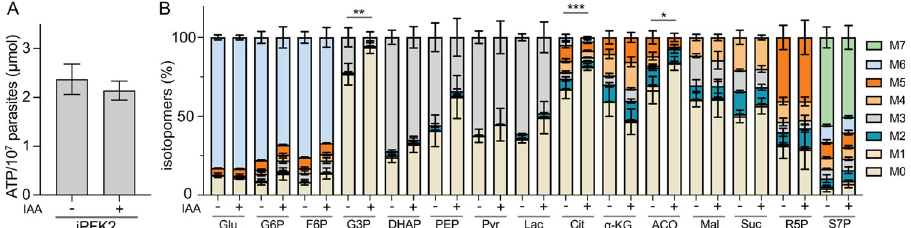
Fig 5. Metabolic alterations associated with PFK2 depletion. A : ATP levels in iPFK2 parasites with or without IAA treatment for 6 hours. B : Incorporation of 13 C into the indicated metabolites in iPFK2 parasites, which were pretreated with or without IAA for 2 hours and then labeled with 13 C 6 -glucose for 4 hours. The 13 C inclusion in each metabolite was determined by LC-MS. M0-M7 denote the number of carbons in a given metabolite that was labeled with 13 C. Means ± SD of three independent experiments, � P < 0.05, �� P < 0.01, and ��� P < 0.001, two-way ANOVA. Details of the statistical analyses are provided in S3 Table.